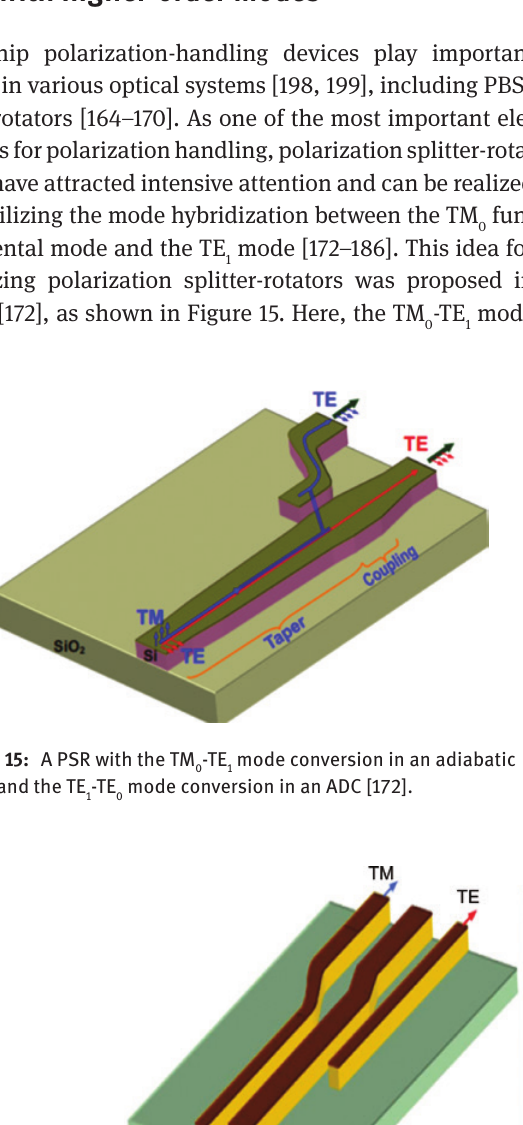
-TM mode conversion. Simulated light propagation in the designed PBS for TE (B) and TM 0 1